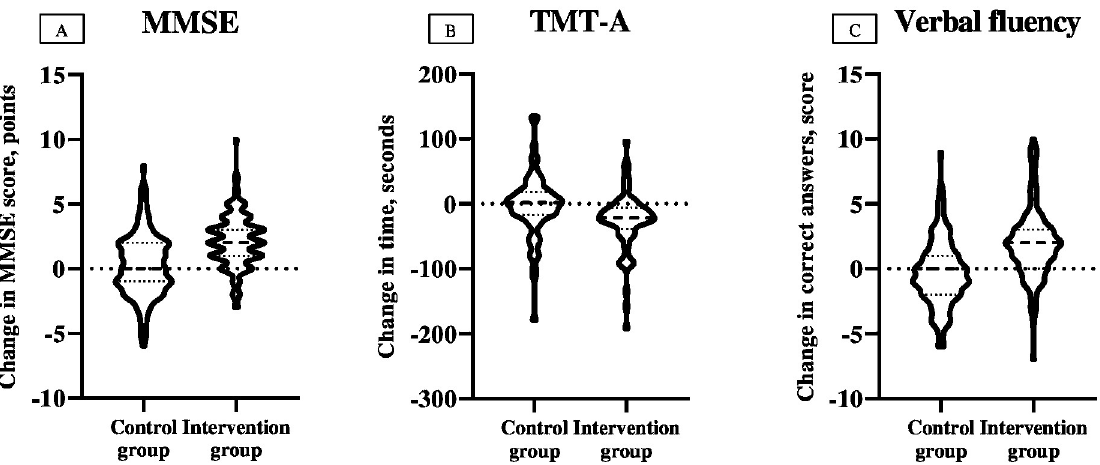
Fig 3. Changes in within-group punctuation in the MMSE test, TMT-A, and verbal fluency test. In the violin plots, the horizontal dotted lines indicate Q1 and Q3, and the horizontal dashed line within the violin, median. MMSE, Mini Mental State Examination;